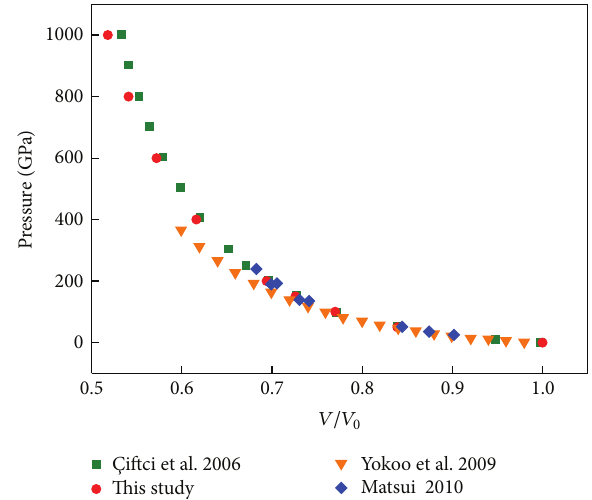
Figure 1: A comparison for the P-V equation of state for Au between 0 GPa and